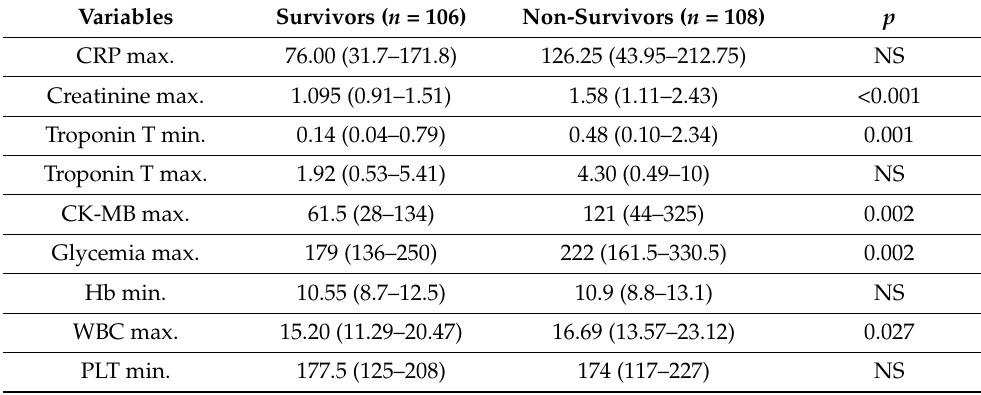
Table 2. The laboratory tests.